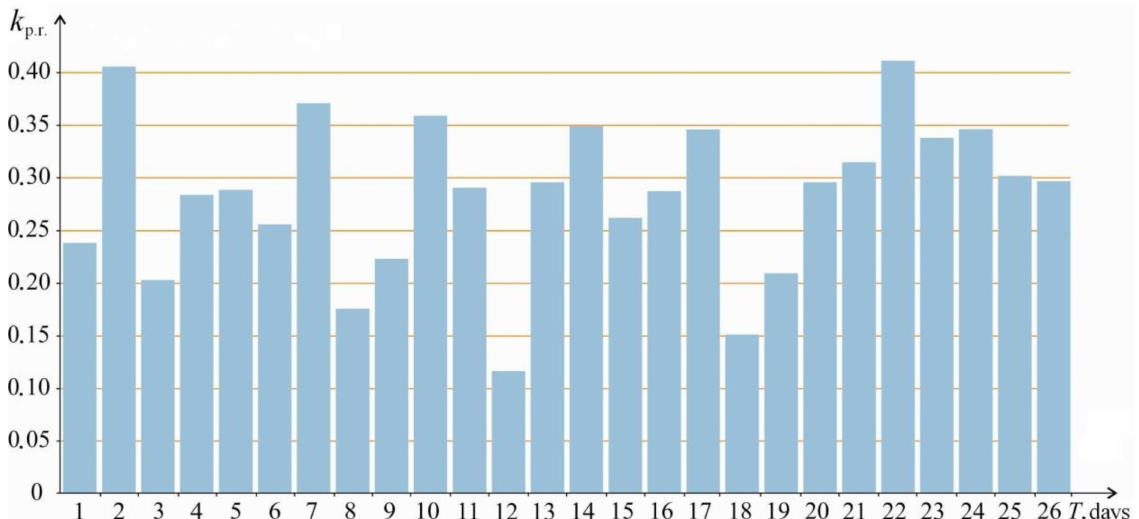
Figure 5. Values of the productivity coefficient for the Ural-20R